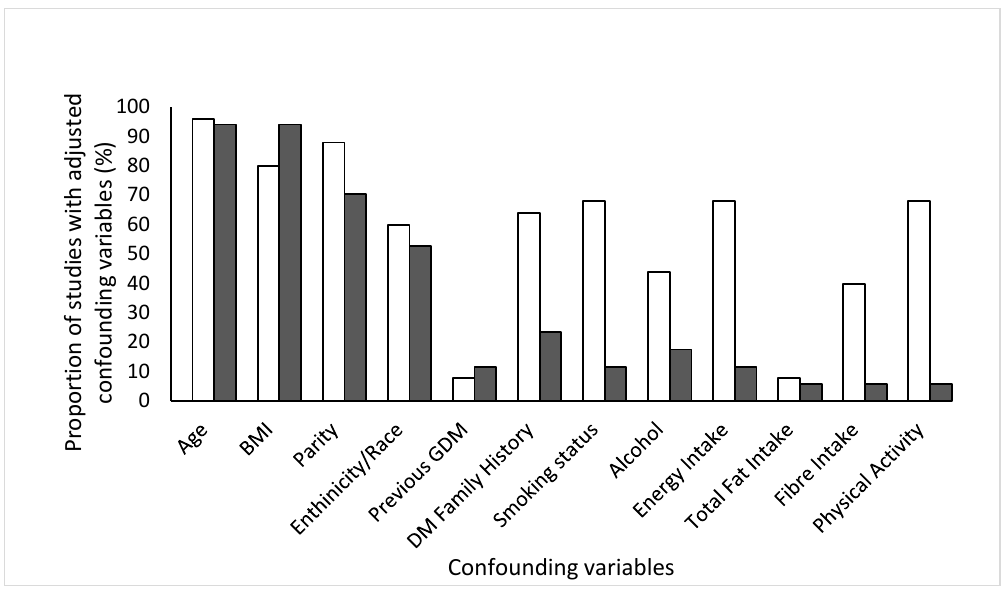
Figure 2. Confounding variables that were adjusted for in studies collecting information on dietary intake (white bars) and physical activity levels (black bars). Age, BMI and parity were most commonly adjusted confounding variables in observational studies reporting on either diet or physical activity.